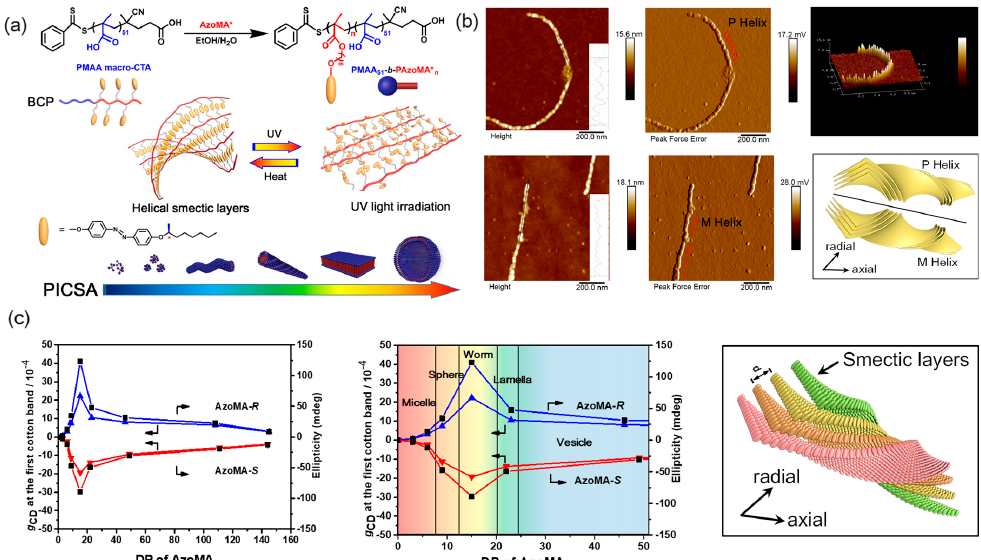
Figure 16. ( a ) Synthetic route of PICSA strategy for constructing hierarchical supramolecular chiral Azo-polymer assemblies. Inset: representation of the dynamic reversibility. ( b ) AFM images and the representation of the helical fibers. ( c ) The maximum CD and g CD values of the supramolecular chiral Azo-polymer assemblies with different morphologies and the representation of the supramolecular helical structure.